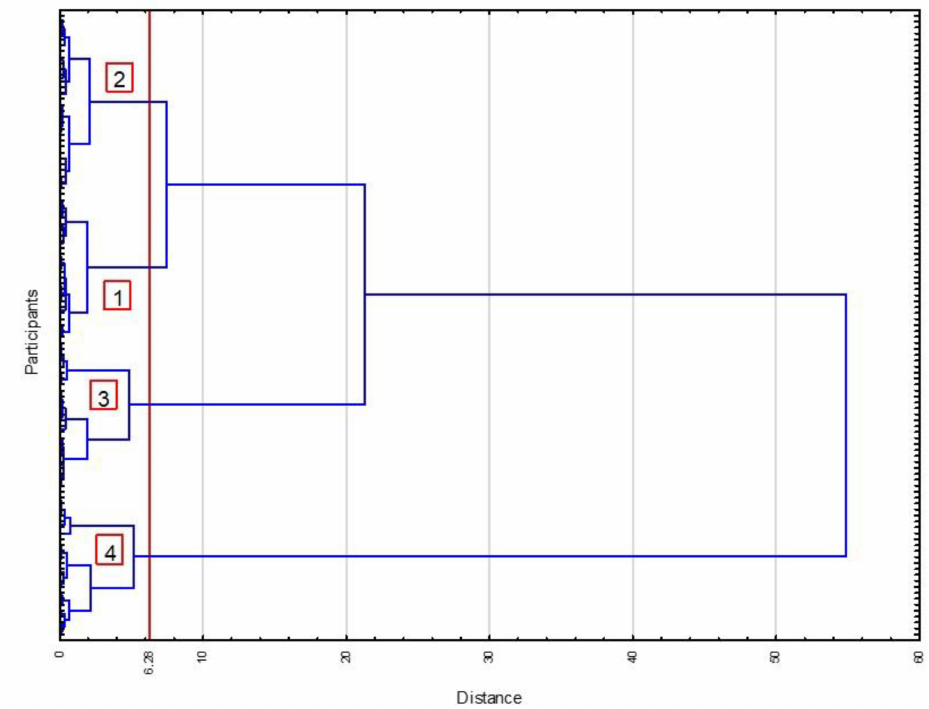
Figure 2. Dendrogram created by the clustering procedure. 1–4—clusters of the participants agglom- erated based on computed regression coefficients for overall stability index regressed on physical activity (PASI, PASI 2 , PASI 3 ); distance—Euclidean distance computed as a measurement of the similarity of the participants inside each cluster and dissimilarity of the participants between